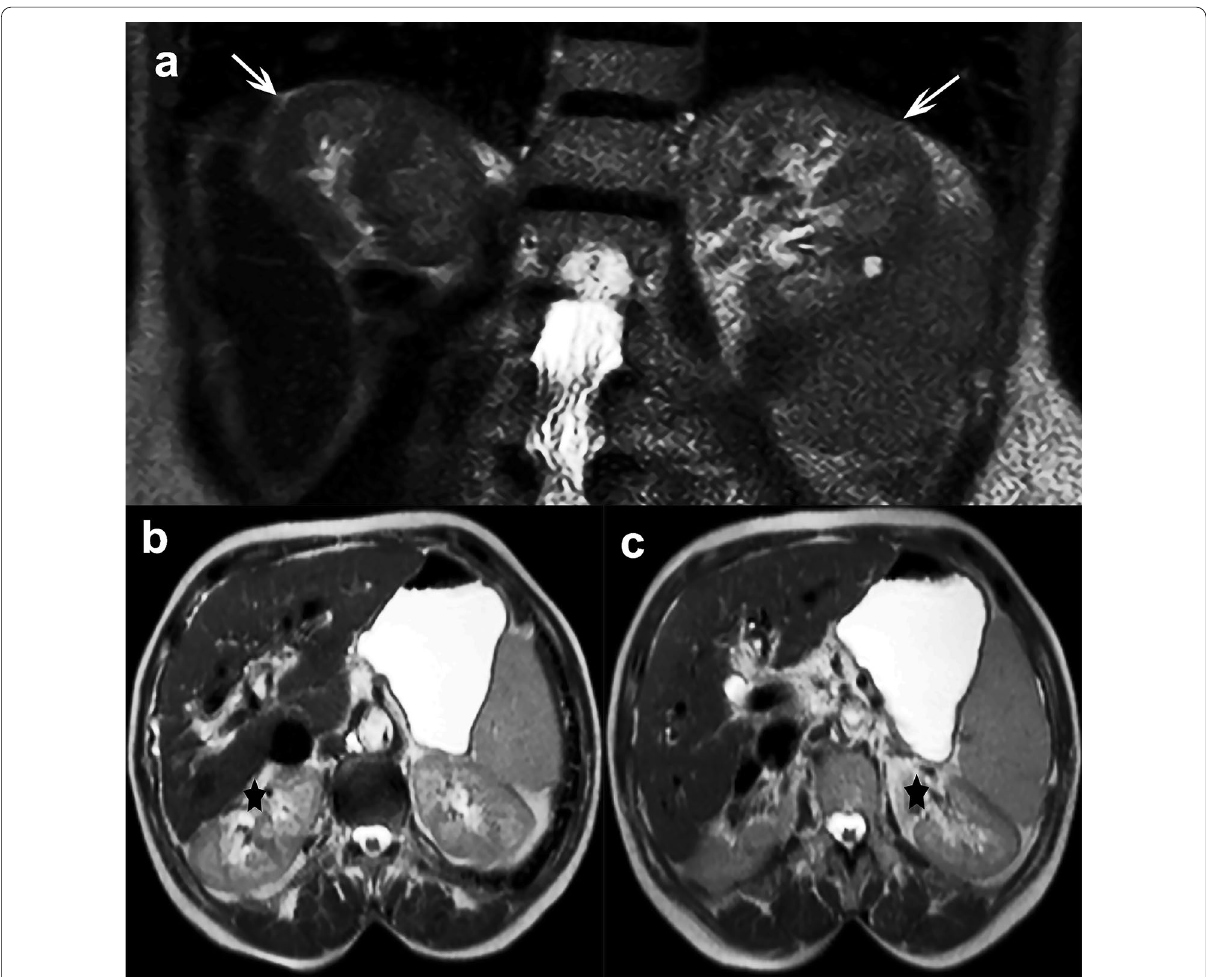
Fig. 2 a Coronal T2-weighted MR image demonstrating the subdiaphragmatic position of both kidneys (white arrows). b Axial T2-weighted MR image demonstrating the anterior direction of the non-rotated right renal hilum (star). c Axial T2-weighted MR image at a higher level, showing the normal medial position of the left renal hilum